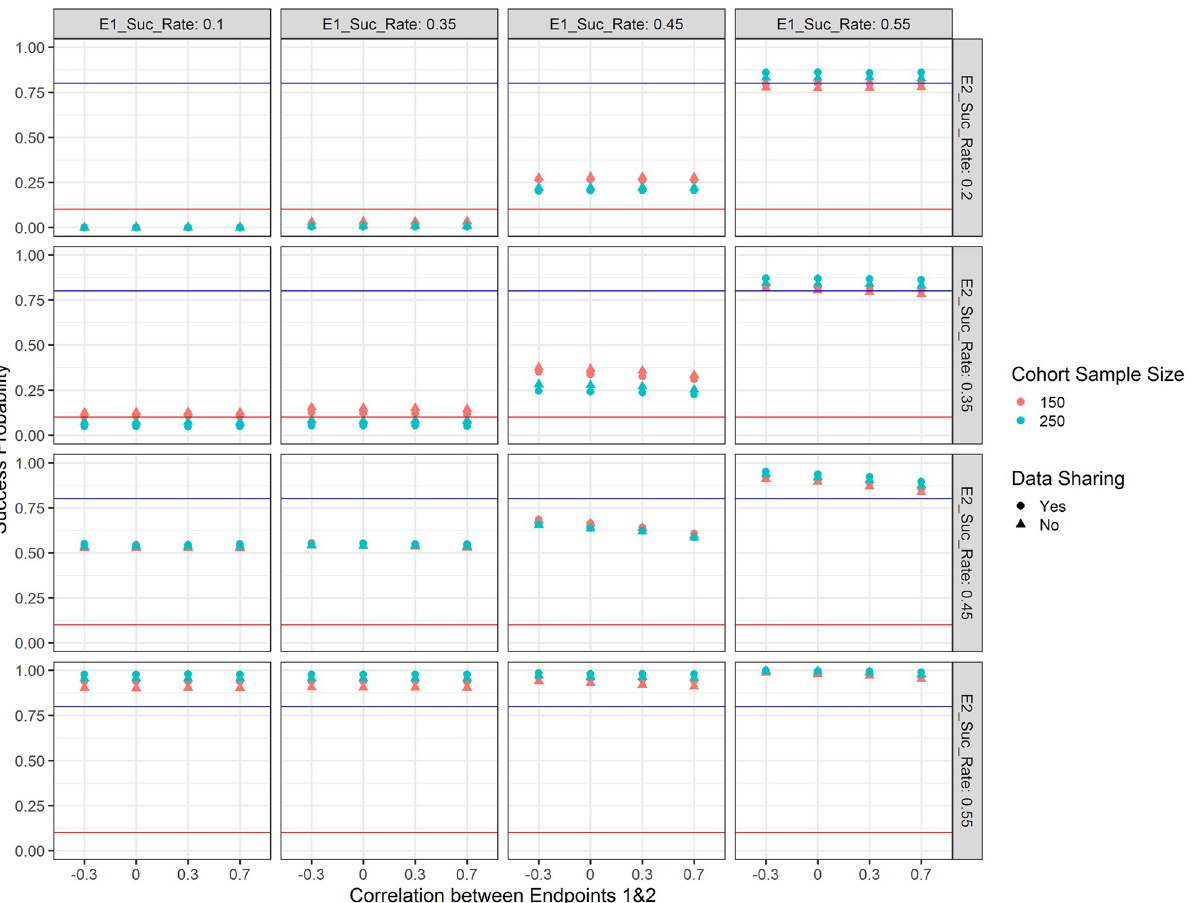
Fig 4. Success probabilities for the treatment arm with respect to the response rate for endpoint 1 (E1_Suc_Rate; columns), the response rate for endpoint 2 (E2_Suc_Rate; rows), the correlation between the two endpoints (x-axis), the type of data sharing used (point shape) and the planned cohort sample size per arm (colour). The blue horizontal line marks 80% as a common target for the power and the red horizontal line marks 10% as a common target for type 1 error in early phase clinical trials. When the drug is truly effective, success probabilities correspond to power; when the drug is not effective, success probabilities correspond to type 1